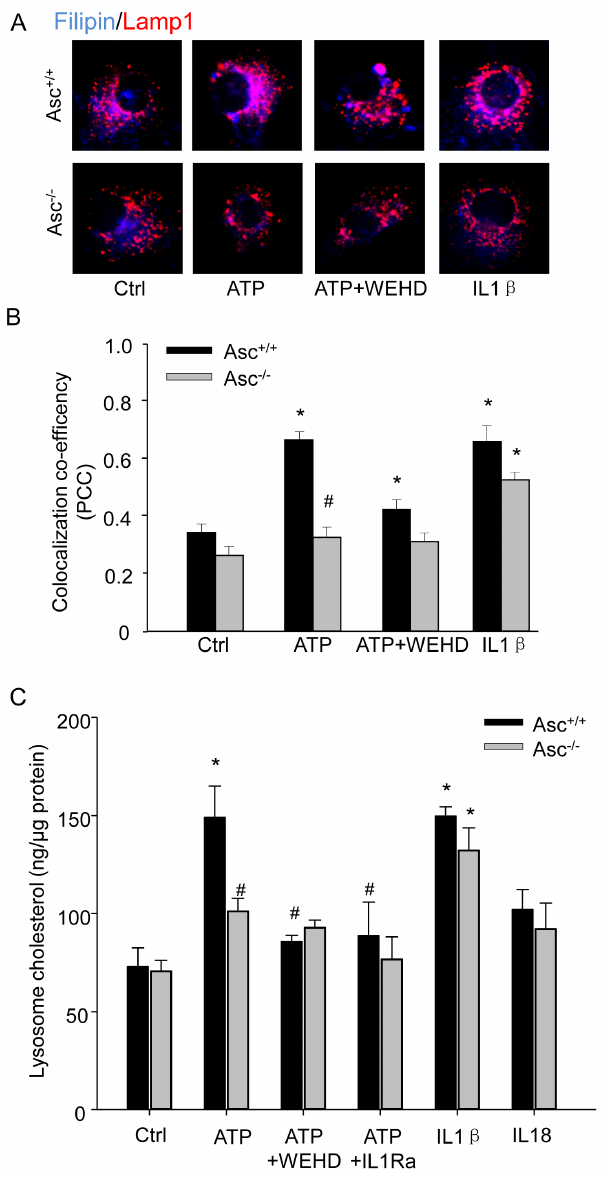
Figure 6. Asc gene deletion and caspase-1 inhibition blocked cholesterol deposition in lysosomes. BMMs were primed with LPS (1 ng/ml) for 3 h and treated with ATP (2.5 mM, 16 h) in the absence or presence of caspase-1 inhibitor WEHD (0.15 m g/ml), or IL1 b (0.5 ng/ml) alone. Then BMMs were loaded with oxLDL (10 m g/mL) for 16 hours. (A) Representative confocal fluorescent images showing the colocalization between filipin (cholesterol) and Lamp1 (lysosome marker). An increase in the purple color in overlay images indicates increased cholesterol trapping in lysosomes. (B) Quantified and summarized data showing co- localization co-efficiency between filipin and Lamp1. (C) Effect of Asc gene deletion on cholesterol level in isolated lysosomes from BMMs. Lysosomes were isolated from Asc + / + and Asc 2 / 2 BMMs and cholesterol concentration in these isolated lysosomes were determined using a standard fluorescence assay kit. Some groups of cells were pretreated with ATP in the presence of IL1R antagonist (IL1Ra, 40 ng/ml) or IL18 (25 nM) alone. * P , 0.05 vs . untreated Asc + / + control group; # P , 0.05 vs . Asc + / + ATP group (n=6).